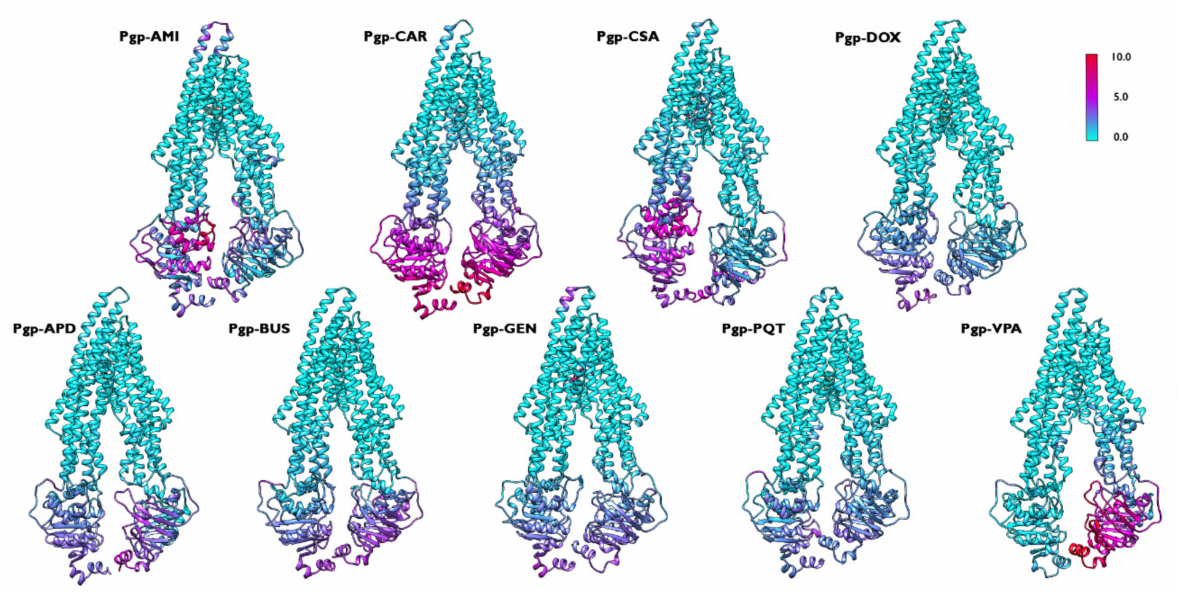
Figure 12. C α -RMSF coloured representation for the simulated P-gp–ligand systems along the first principal component (PC1) calculated from the 500 ns production run. The flexibility scale goes from cyan (lower values) to red (higher